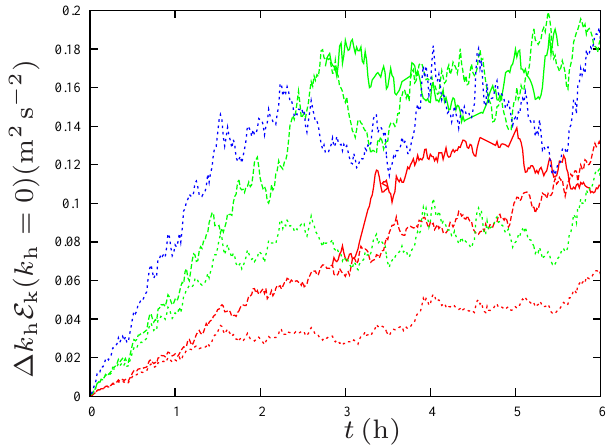
Figure 12. Temporal evolution of the kinetic energy in the shear modes E k (k h = 0 ) for the weak forcing cases (red lines), moderate forcing cases (green lines), and strong forcing case (blue line). Solid lines: 1 = 2m; dashed lines: 1 = 4m; dotted lines: 1 =